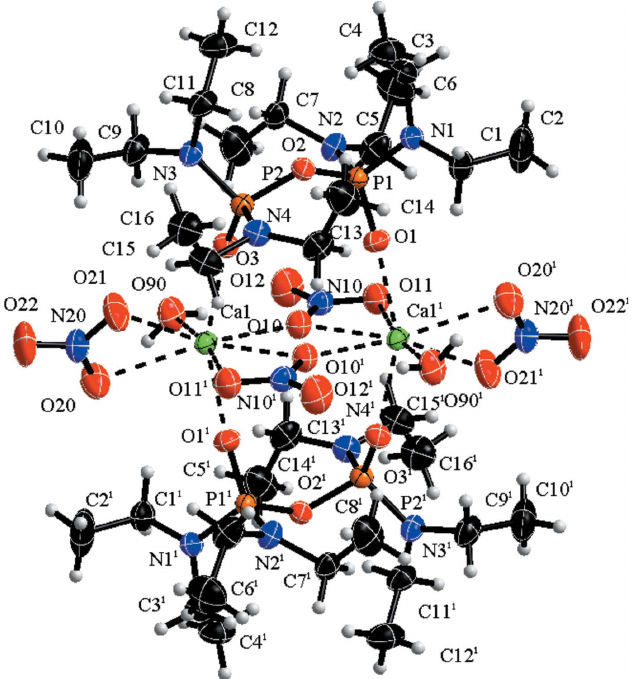
Figure 1 Molecular structure of (I). Displacement ellipsoids of all non-hydrogen atoms are drawn at the 70% probability level. Dashed bonds highlight the eight-coordination around the Ca 2+ cations. [Symmetry code: (i) (cid:4) x + 1, (cid:4) y + 1, (cid:4) z +